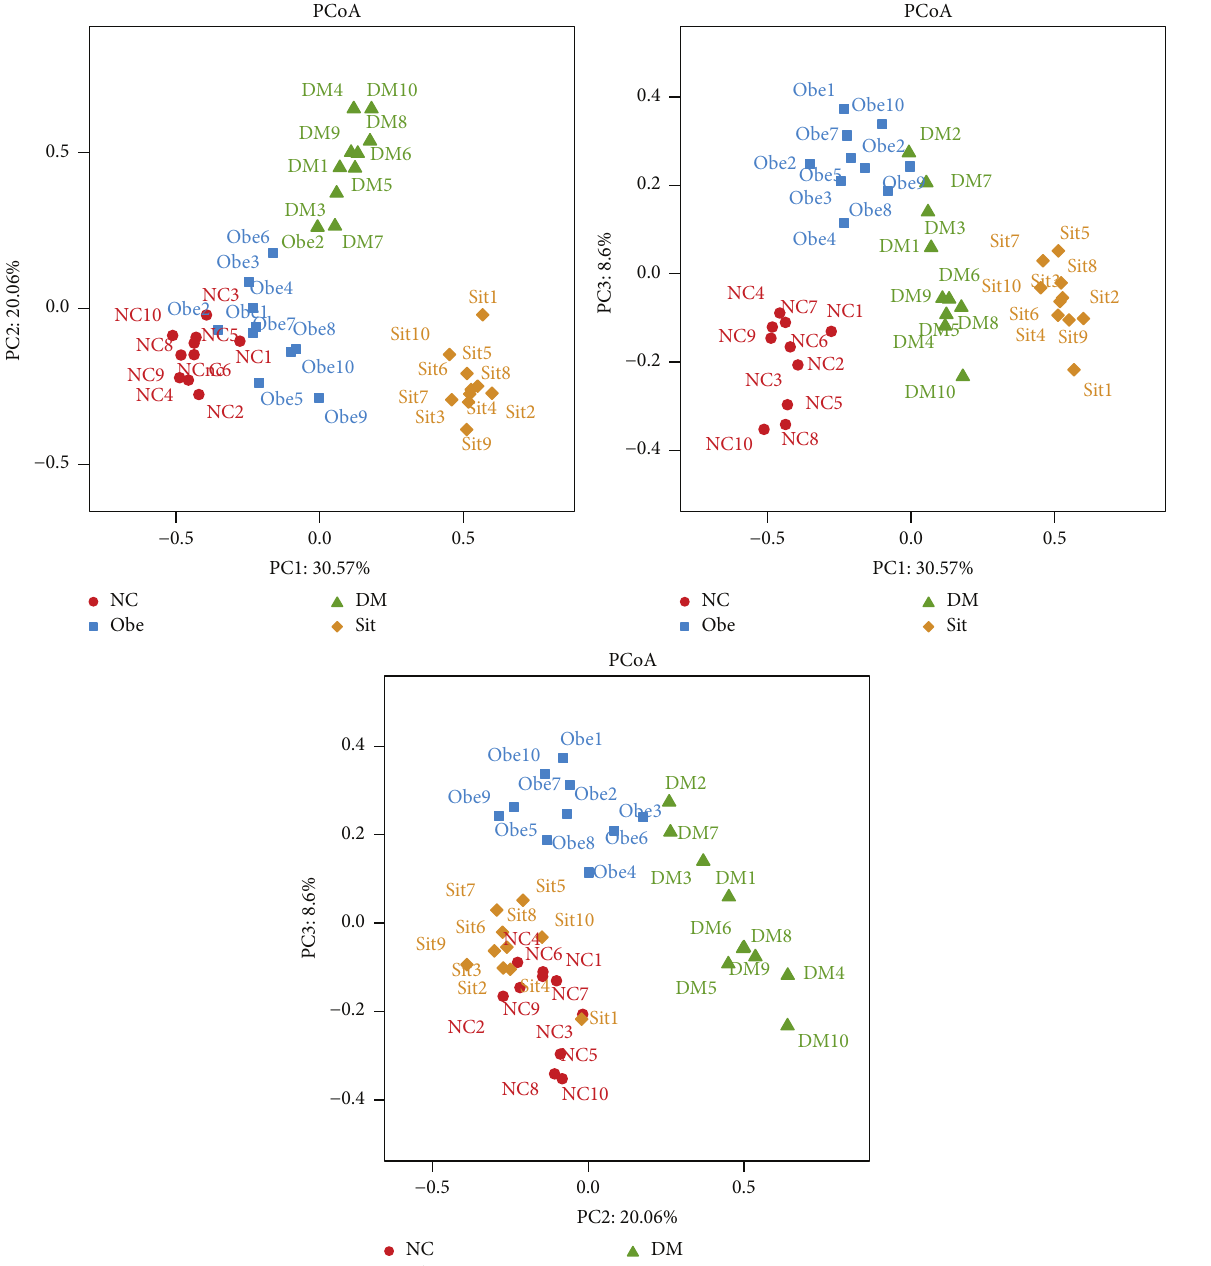
Figure 5: PCA plots based on unweighted Unifrac metrics. Principal components (PCs) 1, 2, and 3 explained 30.57%, 20.06%, and 8.6%. Each symbol represents a